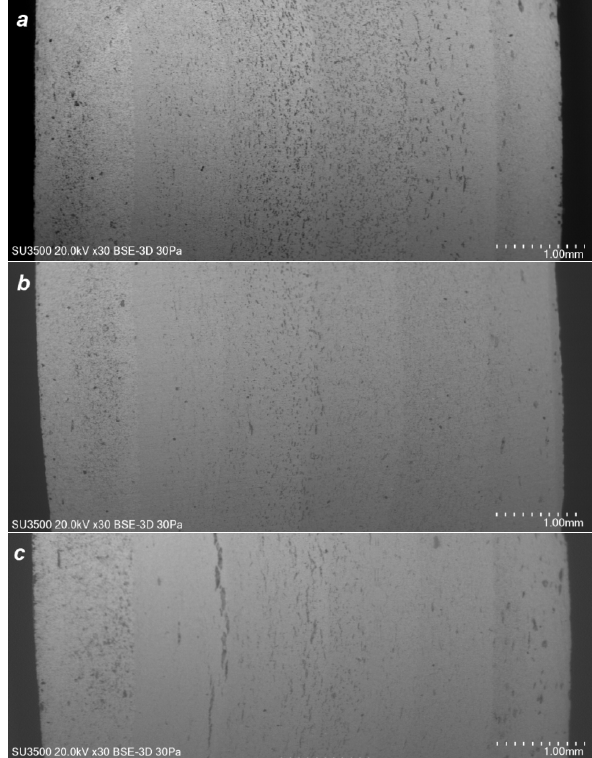
Figure 3: Distribution of gradient layer (a-n 1 = 1, b-n 2 = 2, c-n 3 =